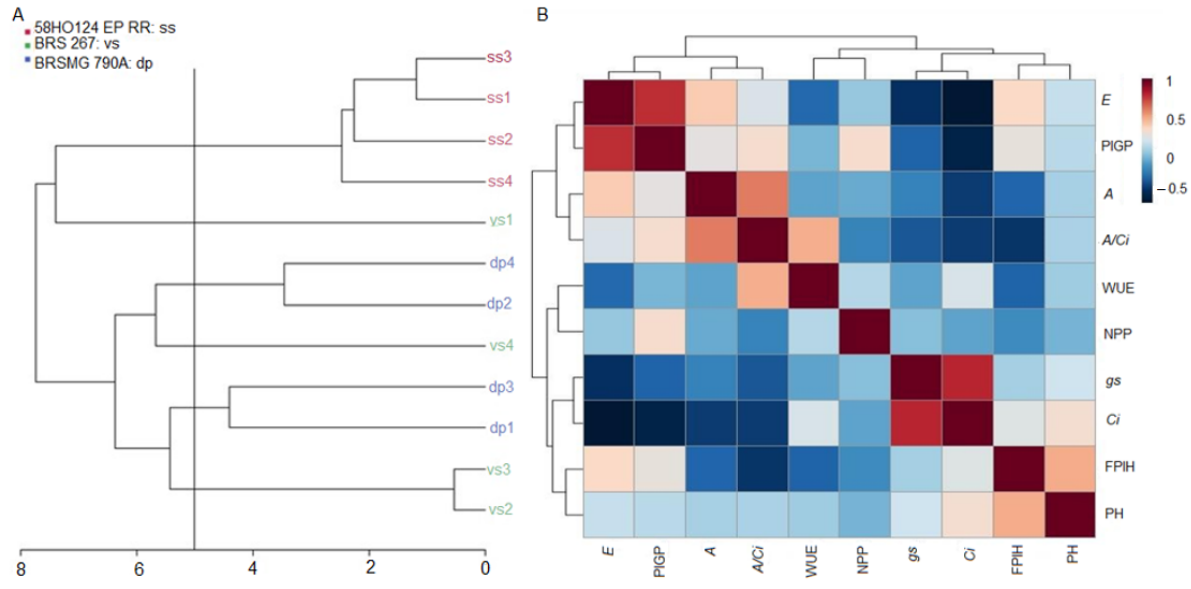
Figure 5. Cluster analysis ( A ) and Pearson graph ( B ) of agronomic characteristics and gas exchange of soybean cultivars. Botucatu, SP, Brazil, 2021.